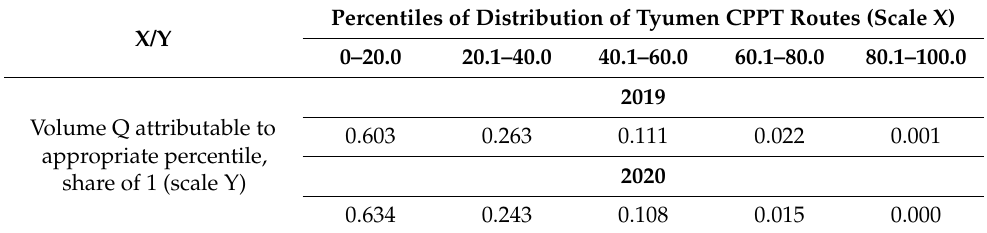
Table 13. Distribution of annual transportations volume Q 04 by percentiles of Tyumen CPPT